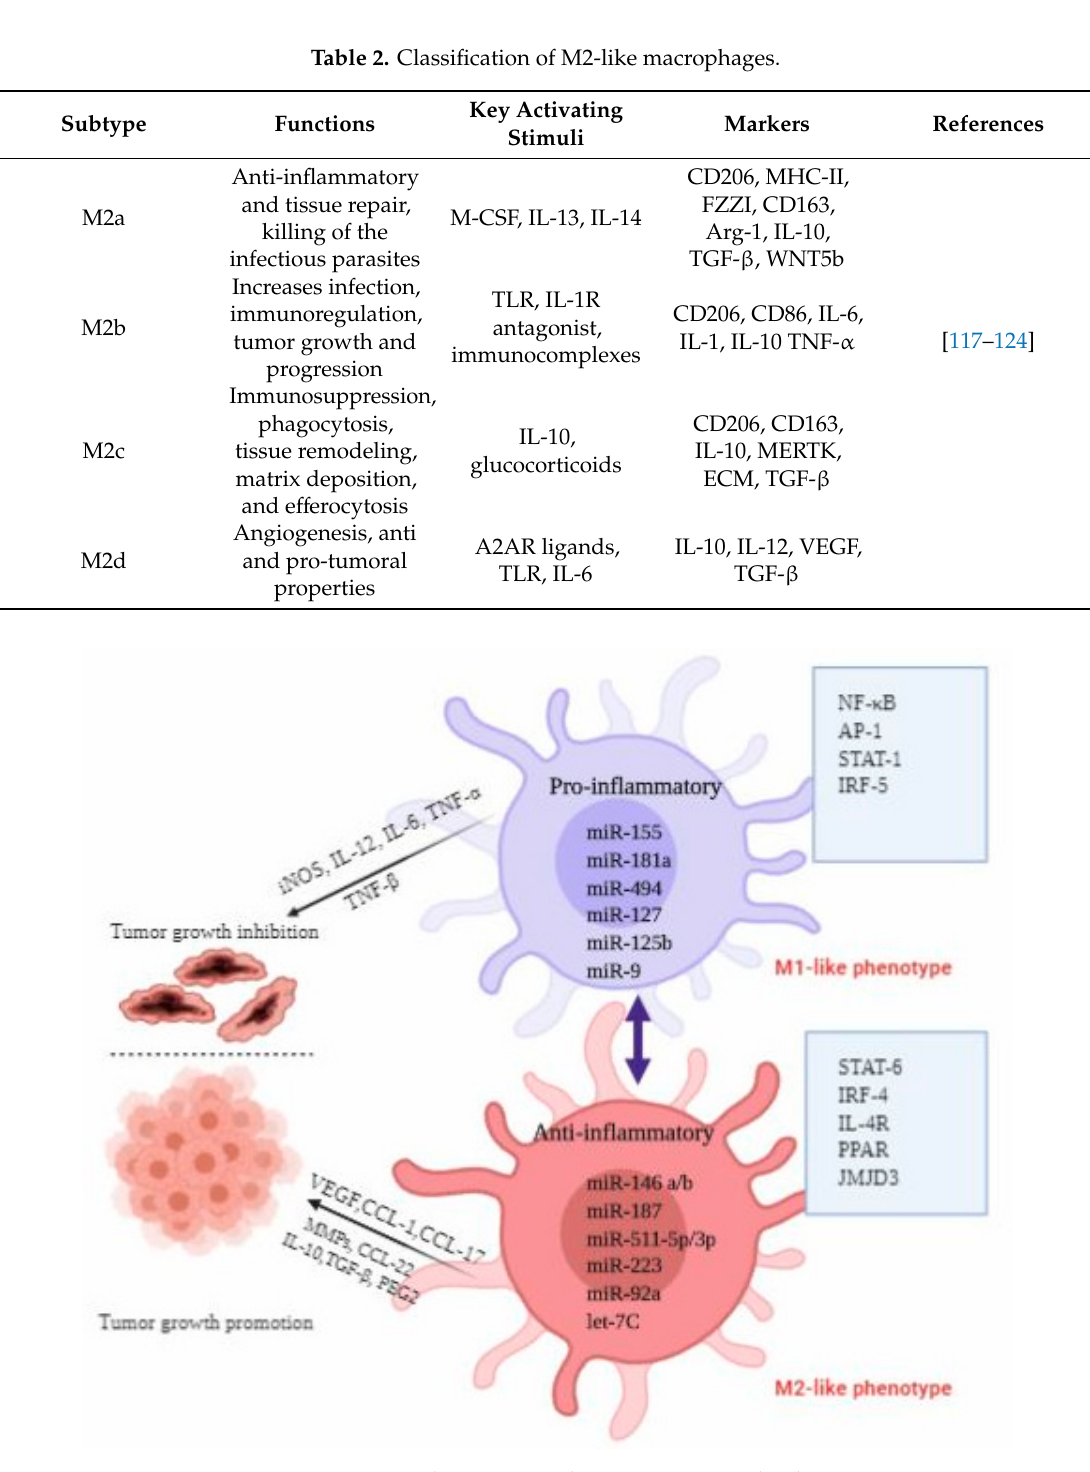
Figure 1. miRNAs regulating macrophage activation and polarization.